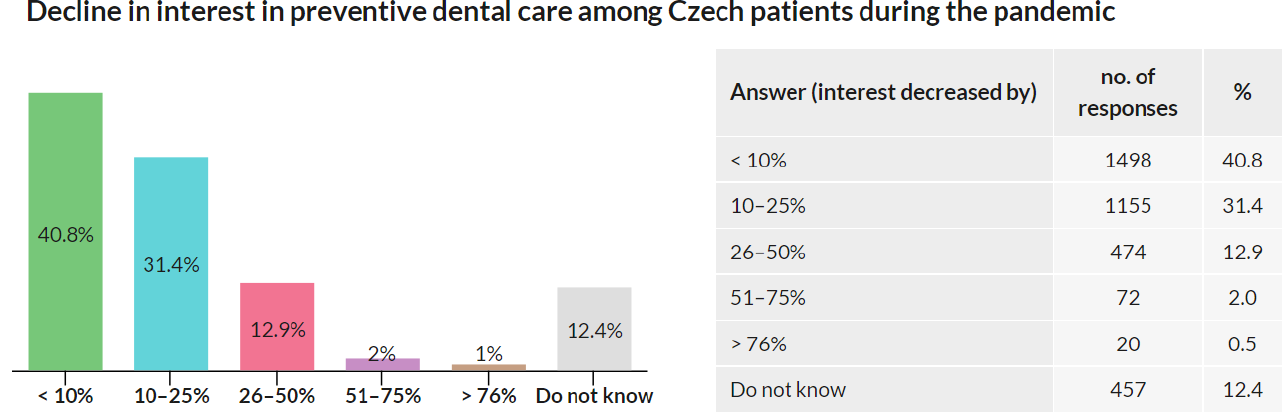
Figure 6. Decline in interest in preventive dental care among Czech patients during the pandemic.